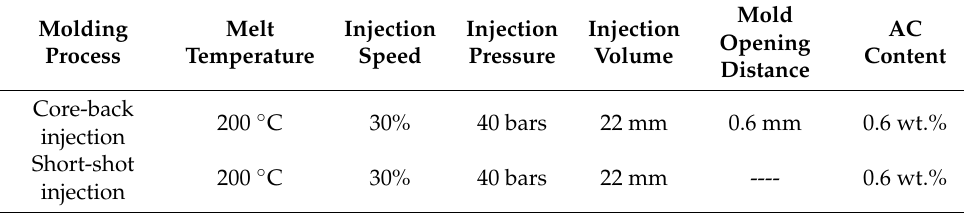
Figure 2. ( a ) Injection molding device diagram, ( b ) The visualization mold diagram. Table 2. Process parameters in core-back injection and short-shot injection.